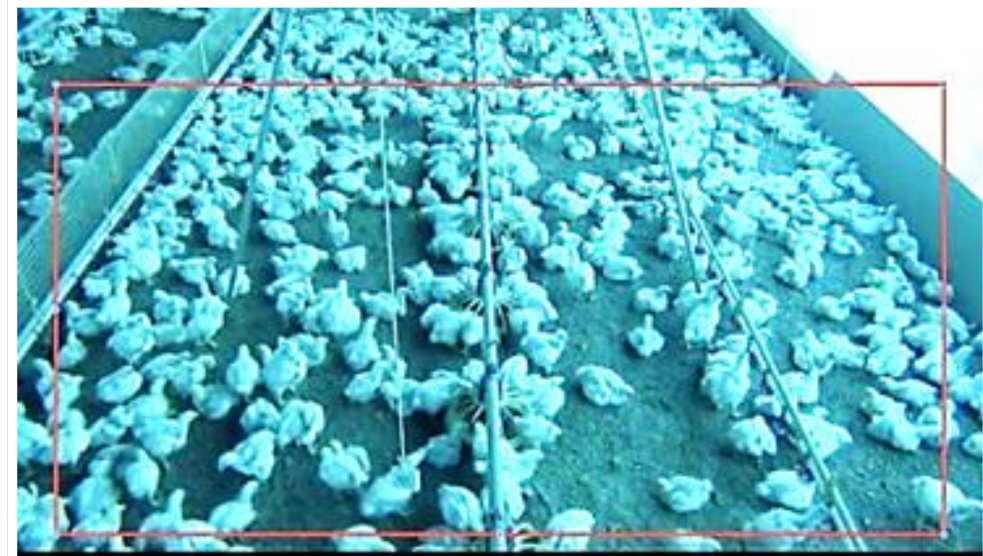
Figure 2. Overview of the delimitation of the video analysis of animal behavior. A weekly observation was conducted with 20 birds per house to identify pododer- matitis lesions. Pododermatitis score was estimated using a scale from 0 to 3 (0 for birds with no lesions, 1 for birds with less than 50% lesions, 2 for birds with between 50% to 100% lesions, and 3 for birds with 100% lesions)